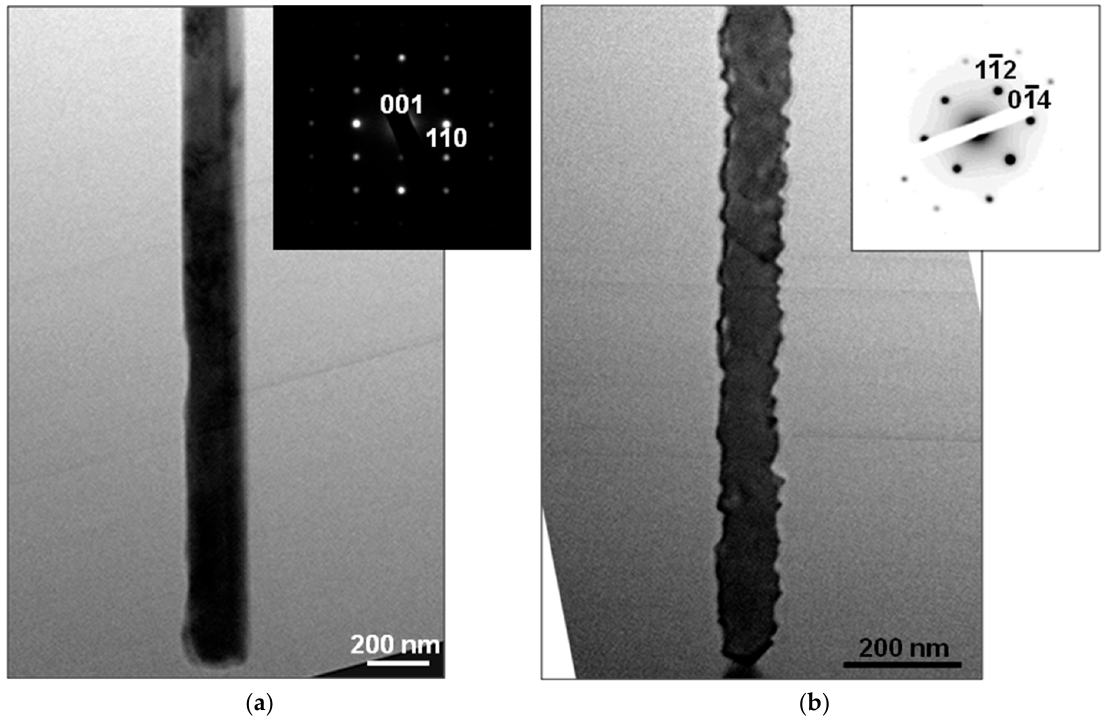
Figure 5. Bright-field TEM images of ( a ) an aragonite needle-like particle and ( b ) a calcite needle-like particle with corresponding SAED patterns. SAED patterns indicate that both particles are single-crystalline.